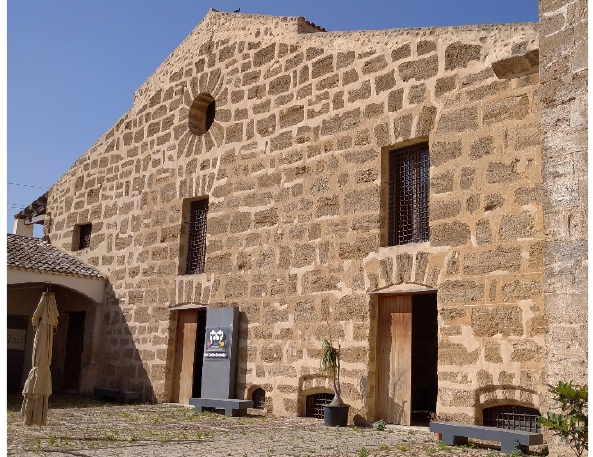
Figure 4 . The main façade of the “ Real Cantina Borbonica ”.